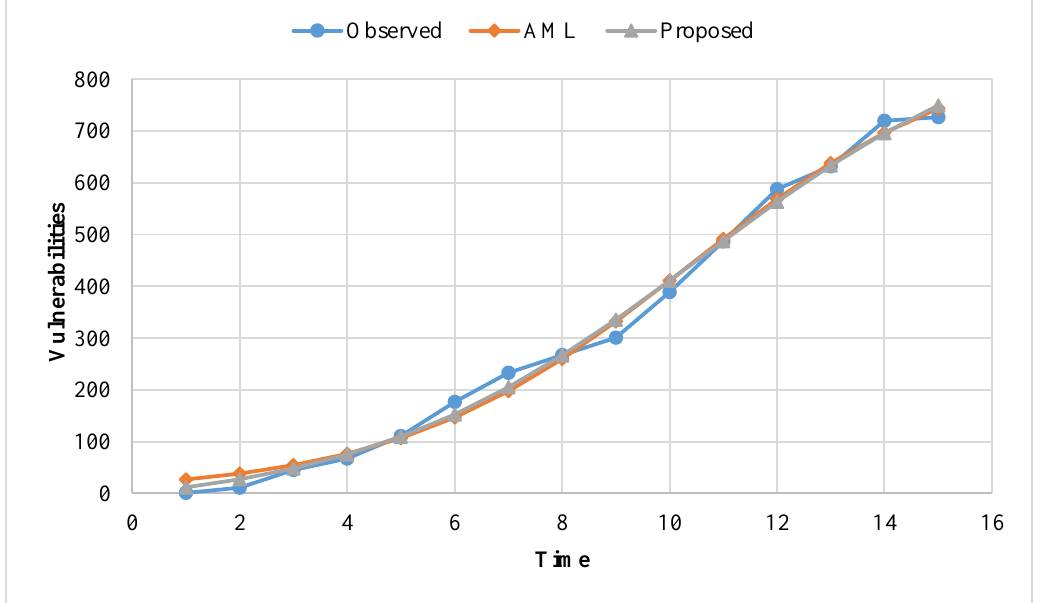
Fig. 3. Goodness of fit curve (Windows